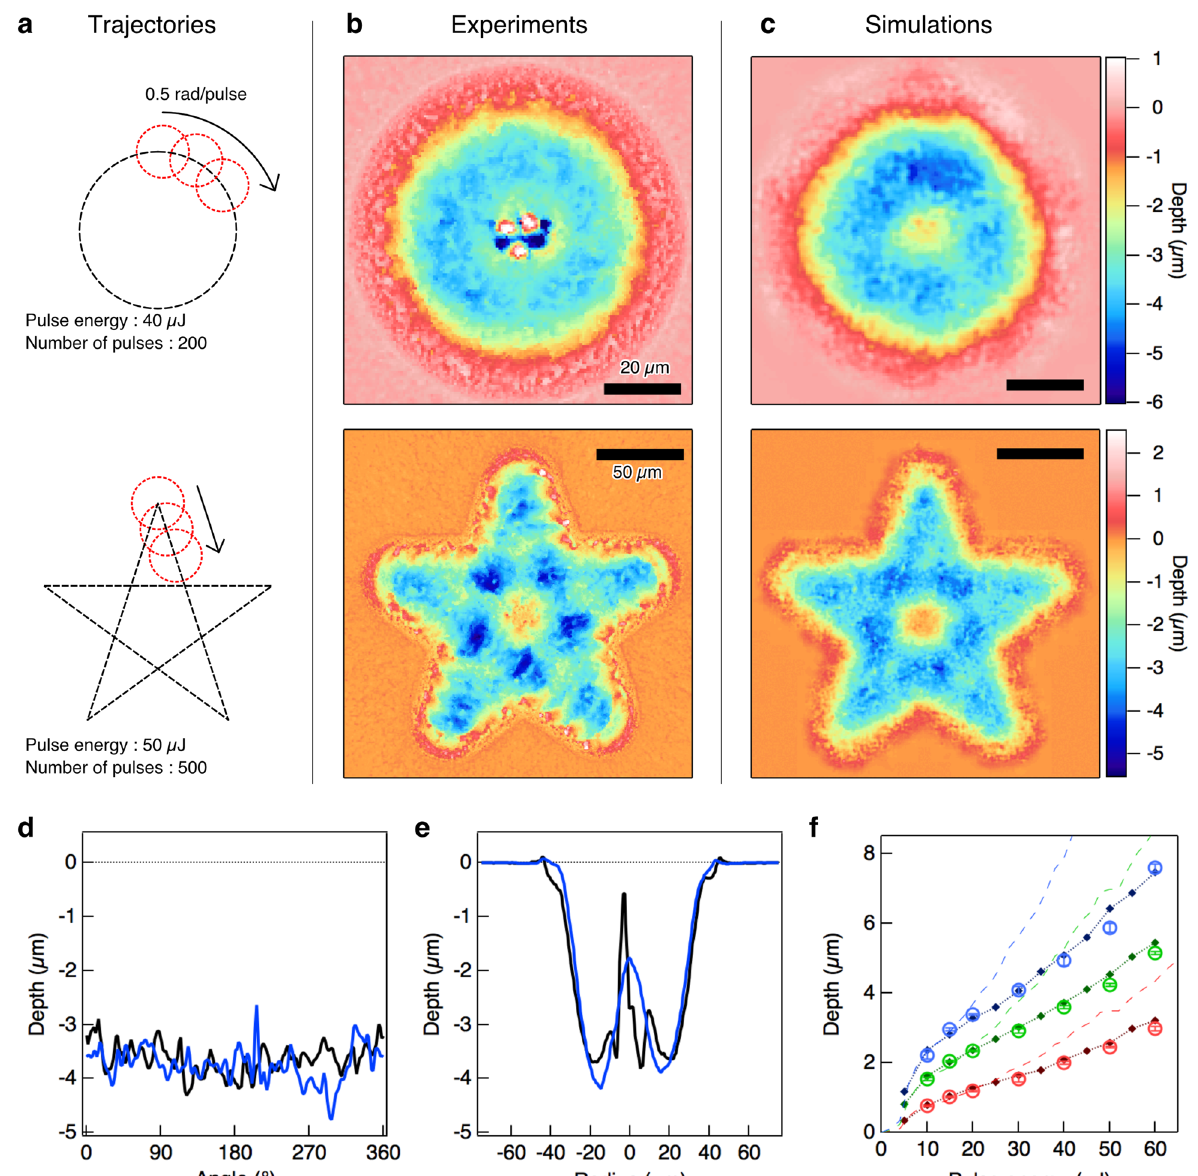
Figure 3. Comparison of experiments with simulations for multi-shot irradiation. ( a ) Trajectories for multi-shot irradiation. ( b , c ) Final depth profiles after irradiation obtained by experiments and simulations, respectively. ( d , e ) One-dimensional depth profiles on circular irradiation from the simulation (blue lines) and the experiment (black lines). ( d ) Depth profiles along the circular trajectory. ( e ) Depth profiles along the radial cross-section (see “Methods” Section). ( f ) Averaged ablated depth along the circular trajectory as a function of the pulse energy from the simulation (open circles) and the experiment (filled diamonds). Intact initial surfaces were irradiated using 100 (red), 200 (green), or 300 (blue) pulses. Error bars for the experimental results were calculated using the standard deviation from three independent measurements. Dashed lines represent the calculation reproduced from the arithmetic mean of the ablated depth over the training datasets for each of the pulse energies (see “Methods” Section). A silicon substrate was used as the test target with 200–2000 pulses at random positions over a ring with an inner radius of 35 mm and an outer radius of 65 mm. The pulse energy was randomly varied over the range from 5 to 75 mJ for each pulse. The number of pulses is chosen to avoid situations where the total ablated depth exceeds 10 µm and the measurement time with the white-light-interference microscope becomes too long. Each single-shot acquisition took 20–40 s, includ- ing the data saving time. After the series of data acquisition measurements, the sample position was moved by 500 mm and another series of measurements was carried out using the same procedure. In this way, datasets on the changes in the depth profile caused by a laser pulse on a fresh surface and on a surface under the processing could be obtained. Datasets that included unmeasurable regions due to insufficient numbers of interferometric